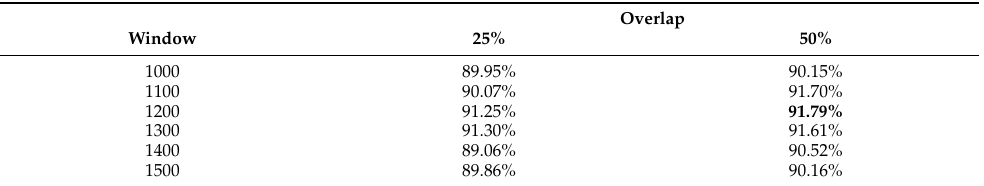
Table 1. Validation set accuracy for different window lengths and overlapping, best result displayed in bold.